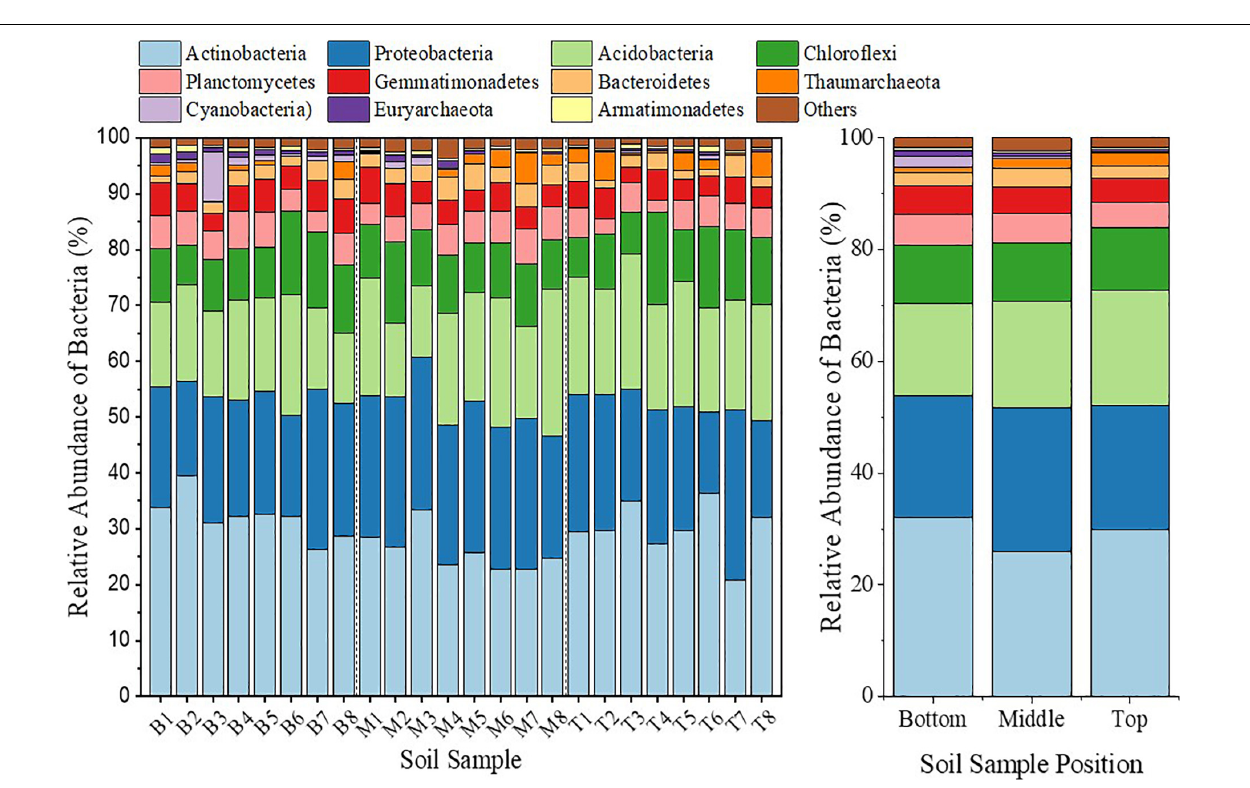
decrease in relative abundance in the middle slope compared with that in the top slope. However, Proteobacteria increased by 15.9%. On the contrary, Actinobacteria increased by 6.8% in the bottom slope compared with that of the top slope, whereas the decrease in Proteobacteria was not